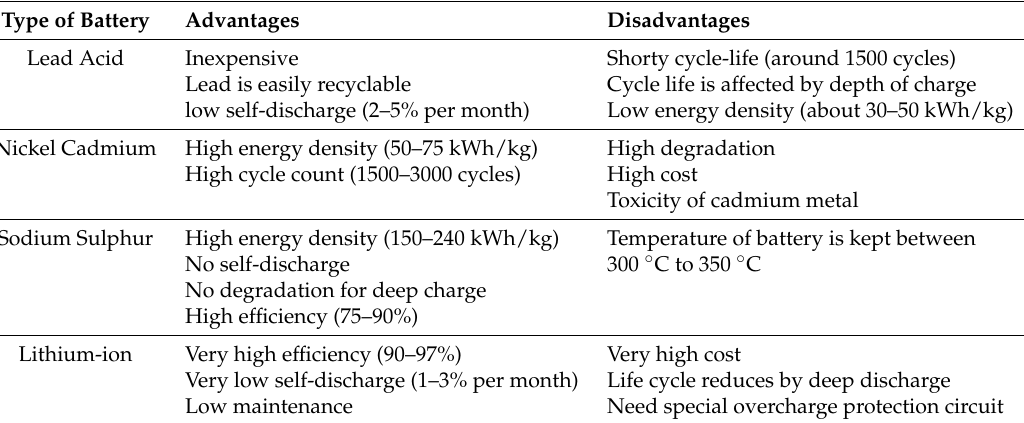
Table 2. Comparison between different battery